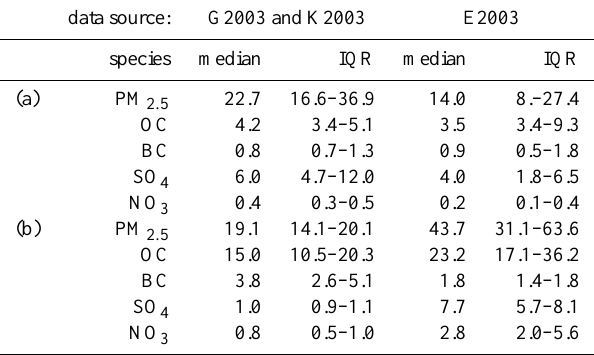
Table 2. Comparison of median aerosol mass concentra- tions ( µ g/m 3 ) and interquartile range (IQR) reported by Gao et al. (2003), G2003, and Kirchstetter et al. (2003), K2003, versus those reported by Eatough et al. (2003), E2003, for samples repre- sentative of Southern Hemisphere African (a) extratropics and (b) tropics. K2003 had a reasonable calibration, while G2003 did not, and these results have not been corrected to account for the miscali- brated flow meters (Sect. 2). E2003 results were based on measure- ments from an independent